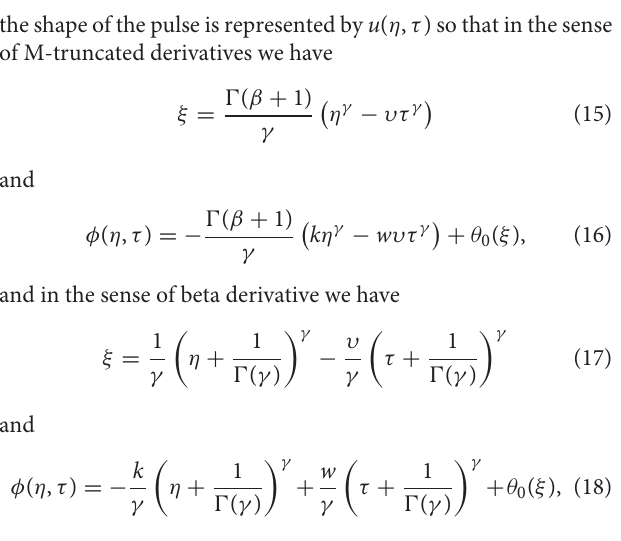
FIGURE 1 | Physical features with suitable values of the parameters. (A) M-truncated with γ with γ 0.5, β 0.9 for (28). (D) Beta with γ = =